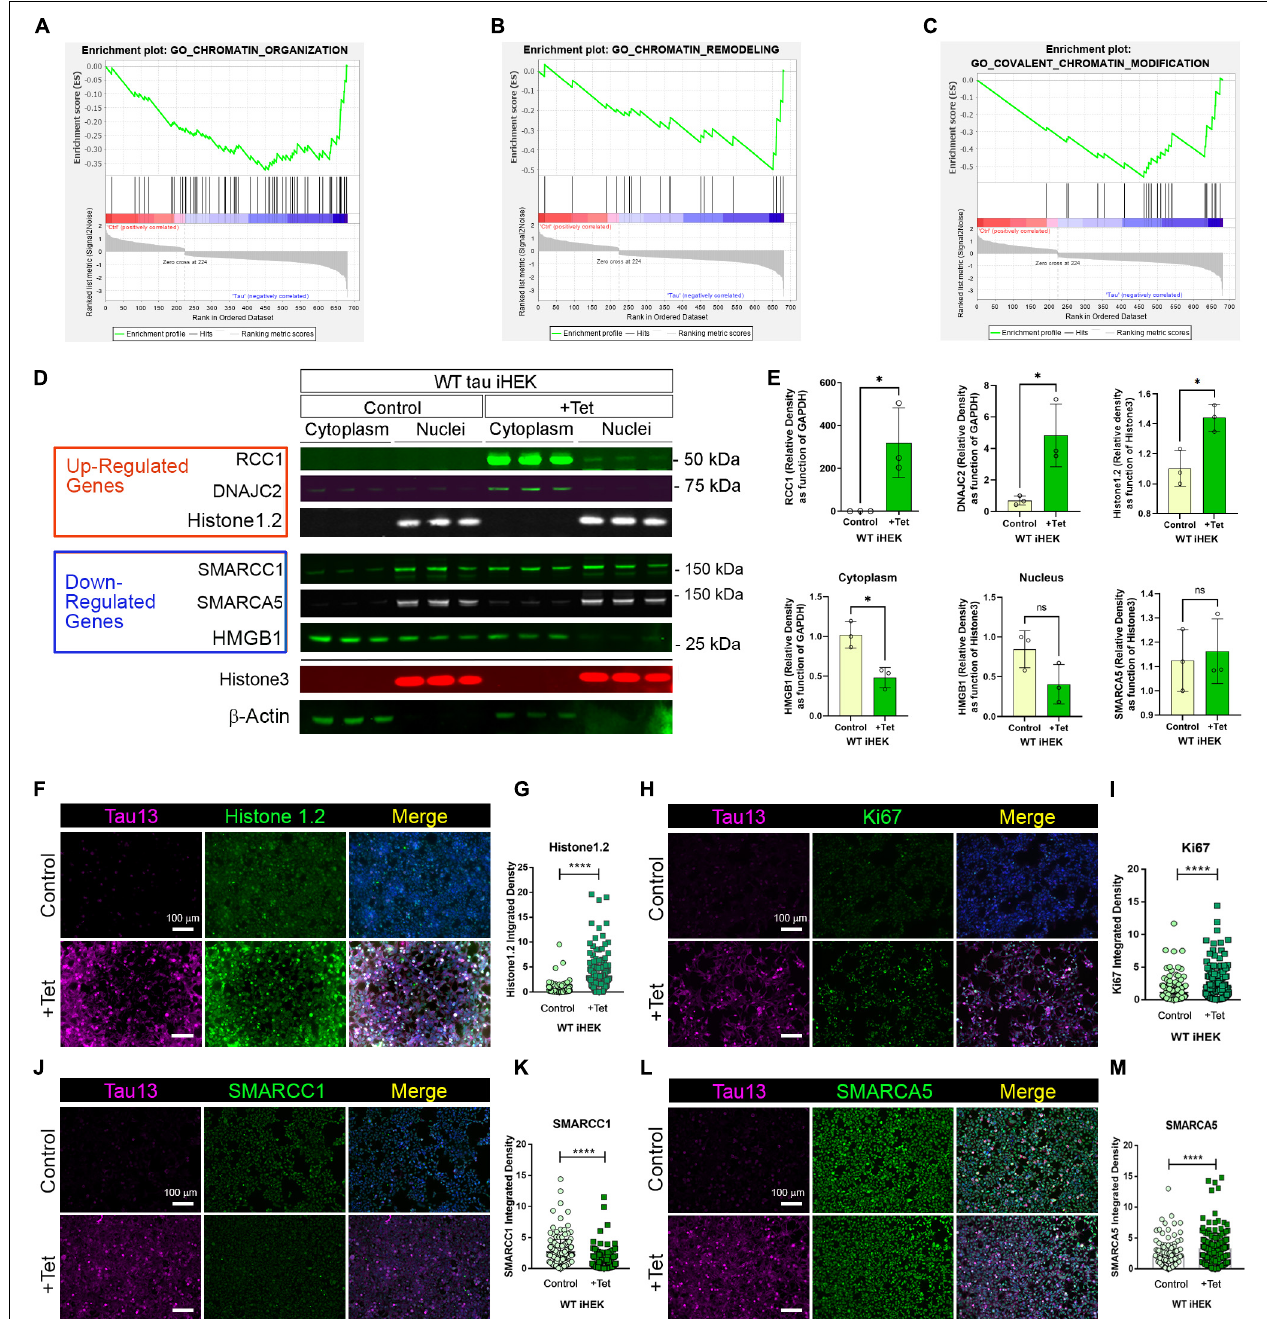
FIGURE 3 | WT tau modulates gene expression of chromatin organization and remodeling factors. (A) Enrichment plot for GO Chromatin organization. (B) Enrichment plot for GO Chromatin remodeling. (C) Enrichment plot for GO-Covalent Chromatin modification. (D) IB of Up-regulated genes: RCC1, DNAJC2 and Histone 1.2 (red box) and Down-regulated genes: SMARCC1, SMARCA5 and HMGB1 (blue box) in cytoplasm and nuclear fractions from WT and P301L tau iHEK. Histone 3 and β -Actin has been used as loading control for nuclear and cytoplasmatic fractions, respectively. (E) Immunoblot quantification of RCC1 (* p < 0.01), DNAJC2 (* p < 0.01), Histone1.2 (* p < 0.01), cytoplasmic HMGB1 (* p < 0.01), nuclear HMGB1 and SMARCA5 proteins in cytoplasmatic and nuclear fractions of WT tau iHEK. (F) Representative Tau 13 (magenta) and Histone 1.2 (green) Co-IF of control (-Tet) and treated WT tau iHEK. (G) Histone 1.2 integrated density quantification in control and + Tet cells (Unpaired t -test, **** p < 0.0001). (H) Representative Tau 13 (magenta) and Ki67 (green) Co-IF of control (-Tet) and treated WT tau iHEK. (I) Ki67 integrated density quantification in control and + Tet cells (Unpaired t -test, **** p < 0.0001). (J) Representative Tau 13 (magenta) and SMARCC1 (green) Co-IF of control (-Tet) and treated WT tau iHEK. (K) SMARCC1 integrated density quantification in control and + Tet cells (Unpaired t -test, **** p < 0.0001). (L) Representative Tau 13 (magenta) and SMARCA5 (green) Co-IF of control (-Tet) and treated WT tau iHEK. (M) SMARCA5 integrated density quantification in control and + Tet cells (Unpaired t -test, **** p < 0.0001).